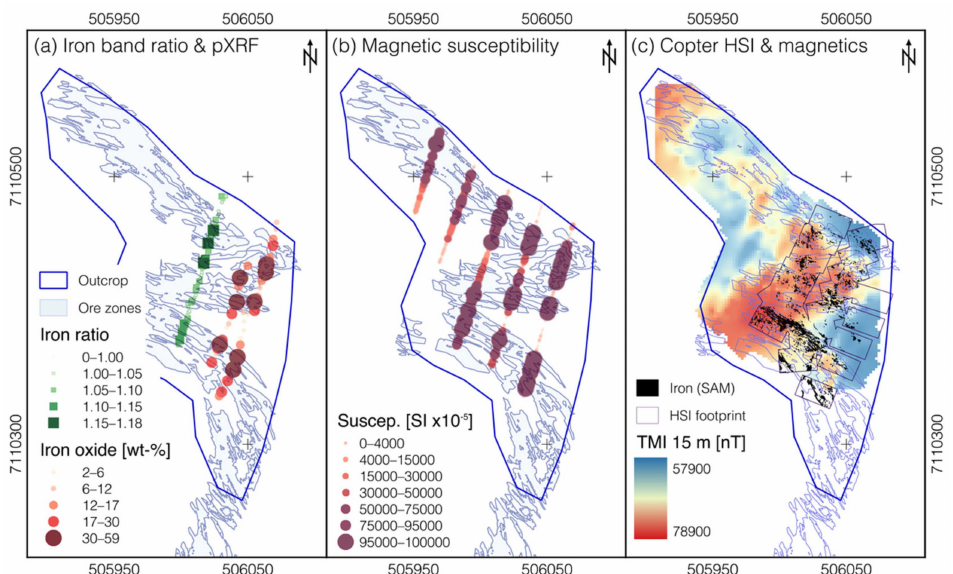
Figure 14. Comparison of ground-based measurements and multi-copter magnetic data. ( a ) Point plot of iron band ratio (760 / 888 nm) from handheld spectroscopy and pXRF values taken along one respectively two sampling lines during the field campaign. ( b ) Point plots of magnetic susceptibility collected by the Otanmäki Mine Oy were measured along five profiles with an inline sampling distance of ~3 cm and line spacing of ~25 m. ( c ) Comparison of iron indications from SAM HSI classification (increased pixel size for better visibility) and TMI map from the multicopter (15 m AGL and 2 m grid spacing). The blue polygons in all three figures sketch the mapped ore